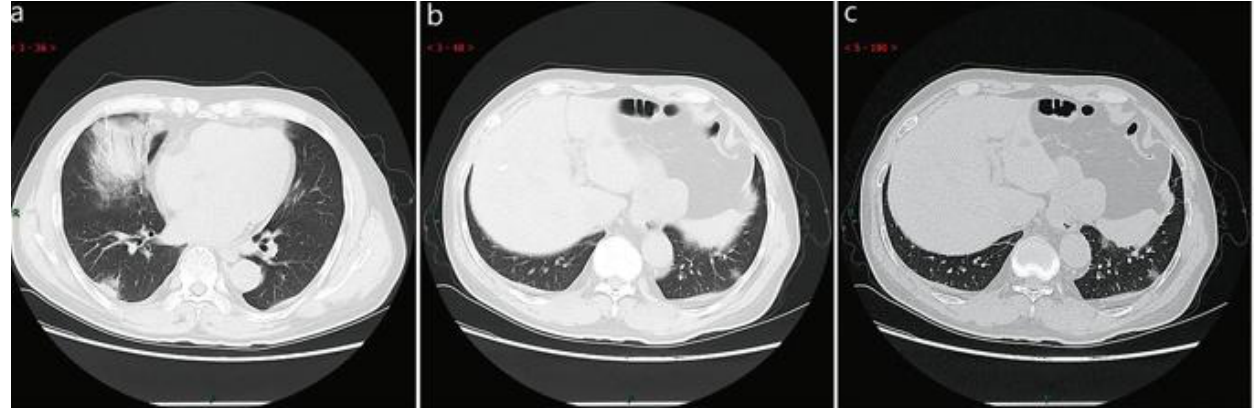
Figure 3: Typical CT / X-ray imaging manifestation (case 3). A 65 years old male with fever for 4 days (38.7 ℃). Laboratory test: normal white blood cells (3.72 × 10 9 /L), decreased lymphocytes (0.9 × 10 9 / L), decreased eosinophil count (0 × 10 9 /L), increased C- reaction protein (53.0 mg/L), increased procalcitonin (0.10 ng/ml), reduced liver function, hypoproteinemia, and mild anemia. Imaging examination: a and b showed large consolidation in the right middle lobe, patchy consolidation in the posterior and basal segment of the right lower lobe, with air-bronchogram inside, c showed patchy consolidation in the outer and basal segment of the left lower lobe, and a small amount of effusion in the right chest. opacity in the basal segment of the left lower lobe